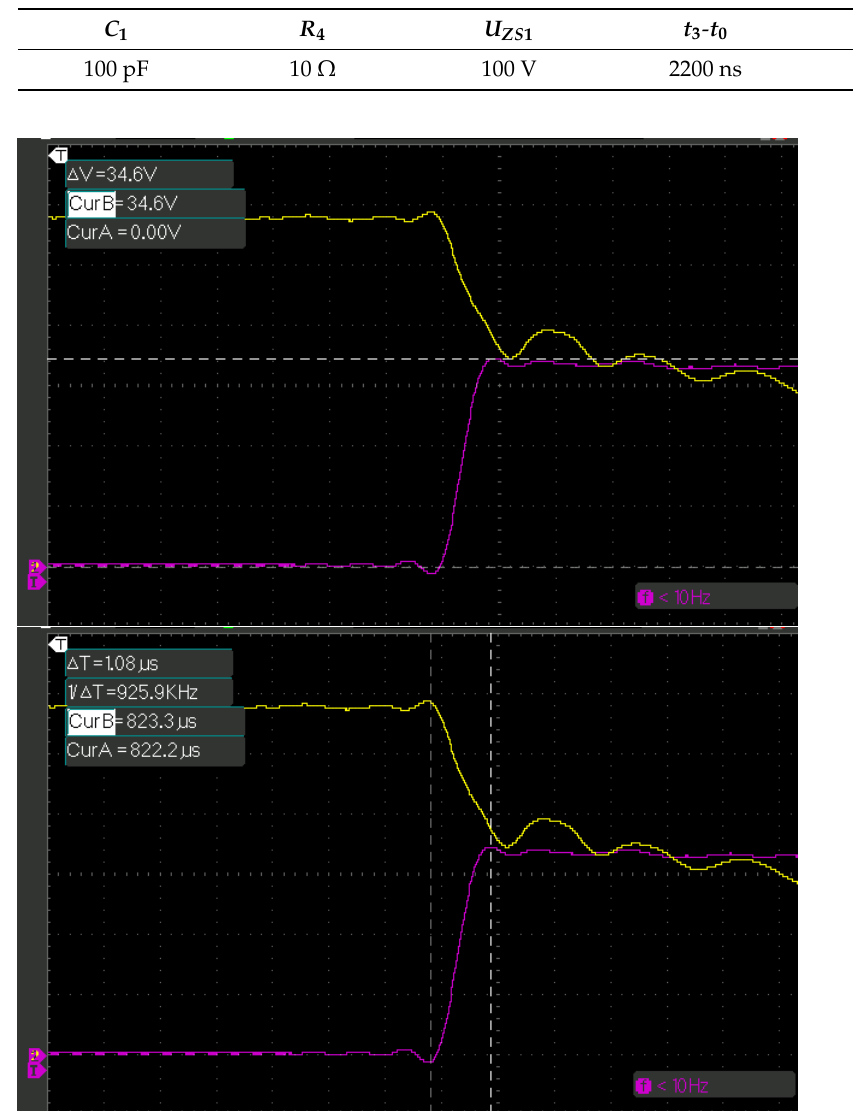
Figure 15. C 1 = 500 pF turn-off waveform. The influence of resistance on the gate signal in the dynamic voltage feedback circuit is analyzed. Compared with R 4 = 100 Ω (Figure 14) and R 4 = 10 Ω (Figure 16), the change in R 4 affects the change in V ge . The smaller the R 4 value is, the slower the decline rate of V ge . In Figure 11, t 3 - t 0 = 550 ns; in Figure 13, t 3 - t 0 = 2.2 µs. During the IGBT off process, with the decrease in R 4 , the feedback signal of the gate increases, which decreases d V ge /dt, and finally extends the time beyond the DC bus voltage V d to reduce the voltage spike. The gate needs to feed back a small voltage signal through the active clamp circuit to suppress the voltage